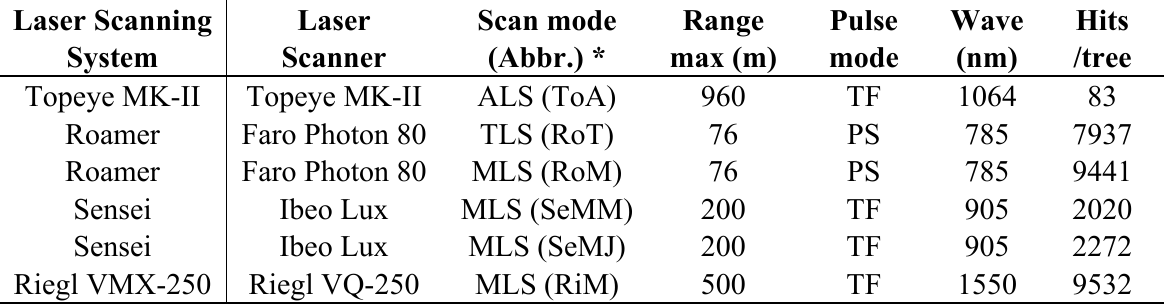
Table 2. The settings of the campaigns for test and the configurations of all of the pulsed laser scanning systems (time-of-flight (TF) and phase-shift (PS)) for data